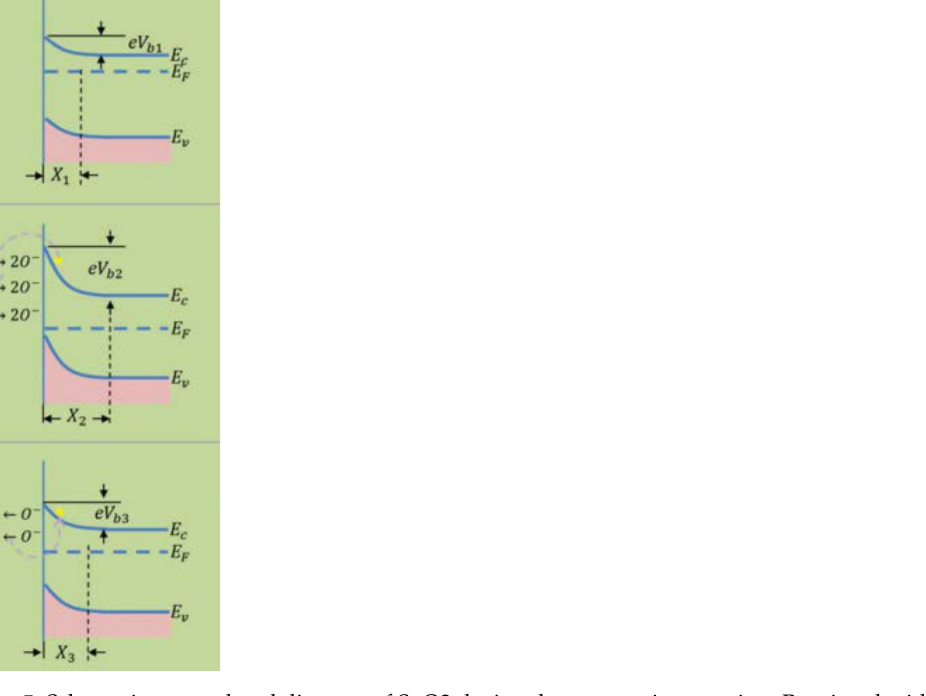
Figure 5. Schematic energy band diagram of SnO 2 during the gas-sensing reaction, “Re- printed/adapted with permission from Ref. [42]. 2016, Li, T. et al.”.